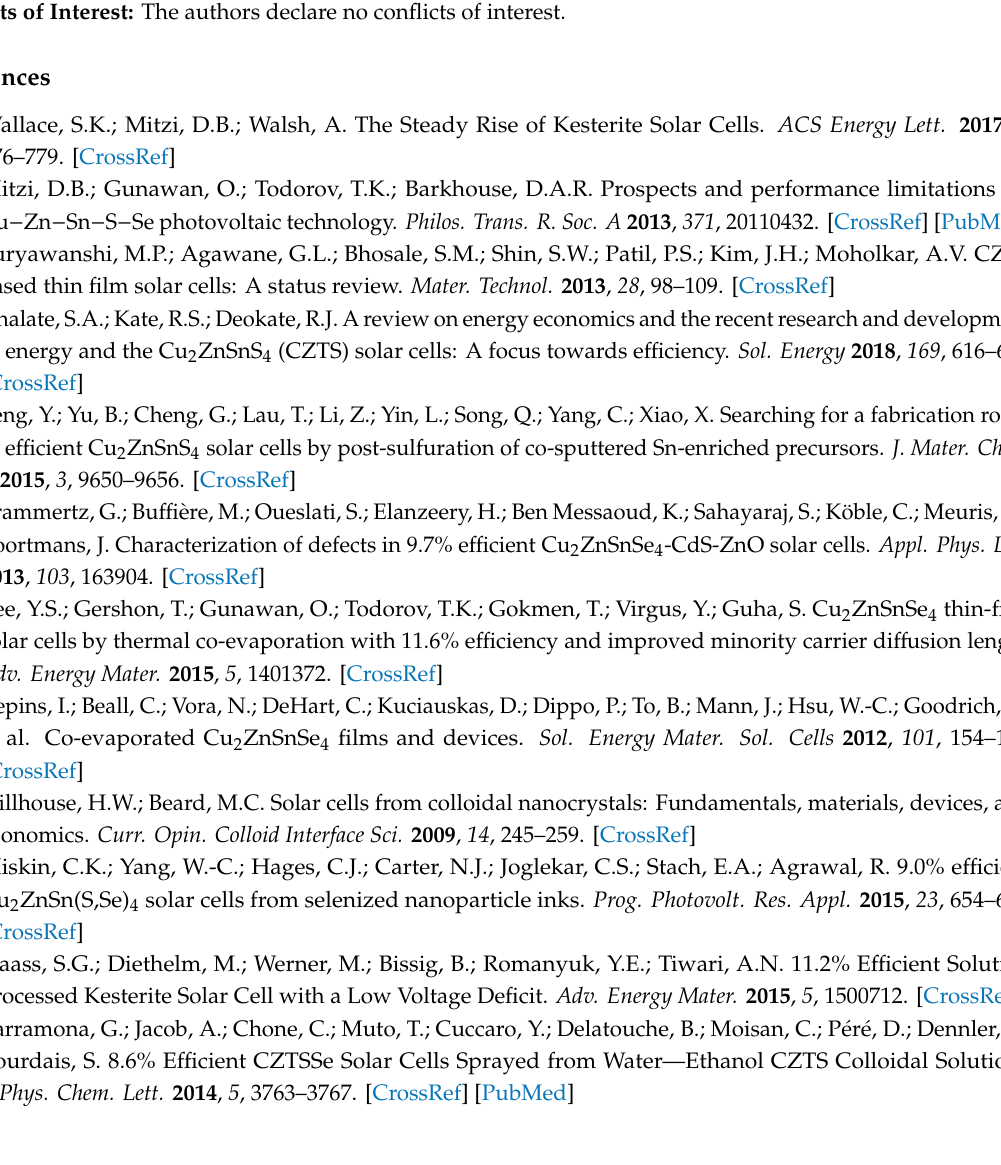
Figure S1: TEM image of hydrothermal nanocrystals of Cu x S and ZnS, Figure S2: XPS spectra comparison of C 1s and Cu 2p after etching adsorbed carbon contamination, Figure S3: Sedimentation test evaluating stability of the nanoink, Table S1. Lattice parameter calculations from experimental XRDs of two sulfurized CZTS thin films made with inks of di ff erent dilution ratio (NH 4 ) 2 S:H 2 O and 170 mg / mL nanoparticle